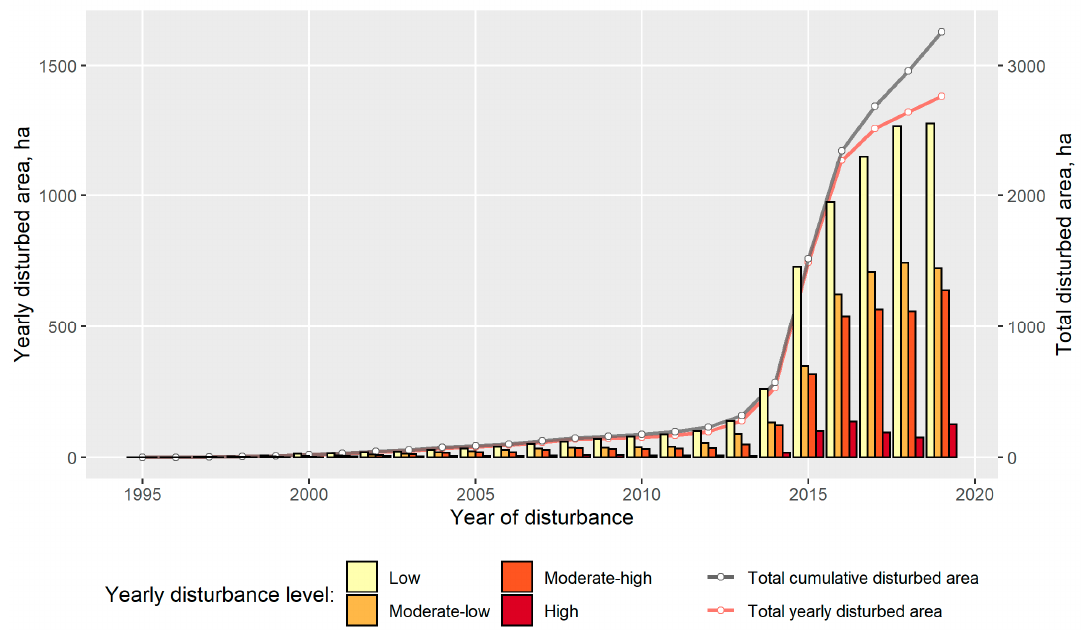
Figure 5. The yearly dynamics of disturbed areas in areas of illegal amber mining (the y -axis is presented using a square root scale).